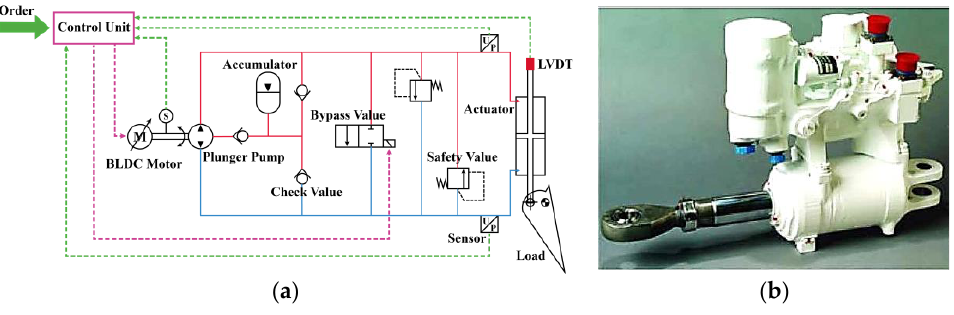
Figure 9. ( a ) Schematic diagram of EHA-FPVS; ( b ) Picture of EHA-FPVS.